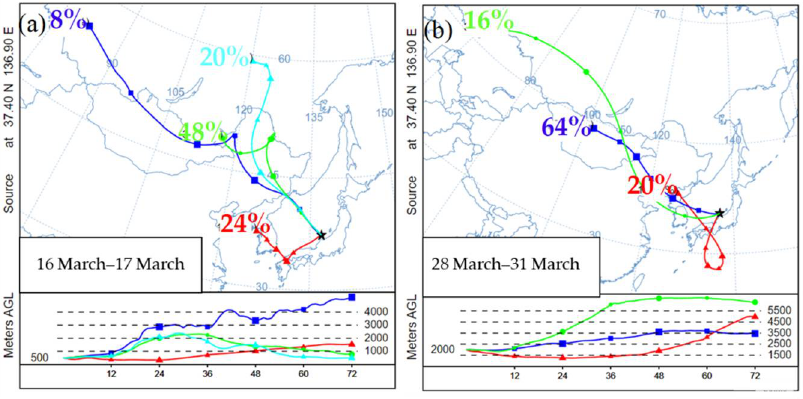
Figure 2. Cluster mean backward trajectory analysis during AD1 ( a ) and AD2 ( b ) and the different colours represent different transport pathways.